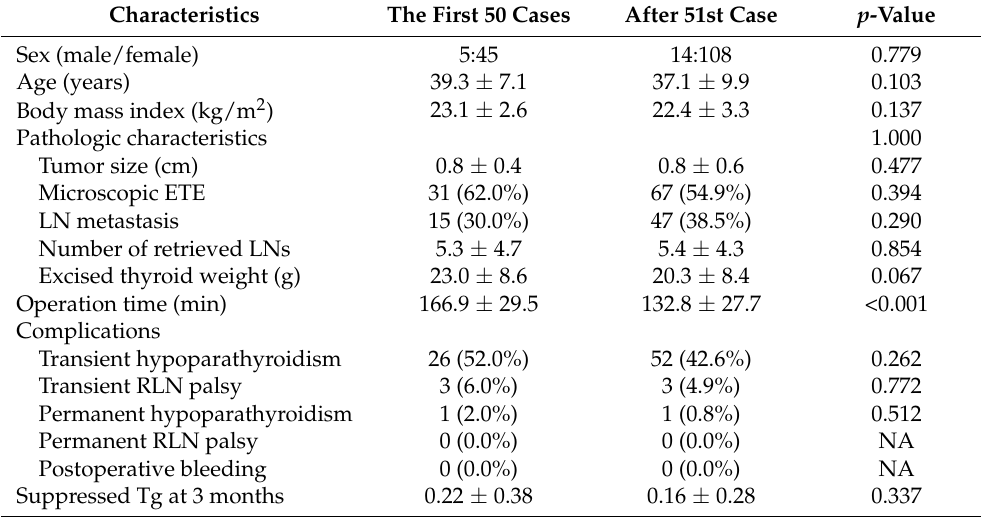
Table 2. Comparison of clinicopathological characteristics between the first 50 cases group and the after 51st case